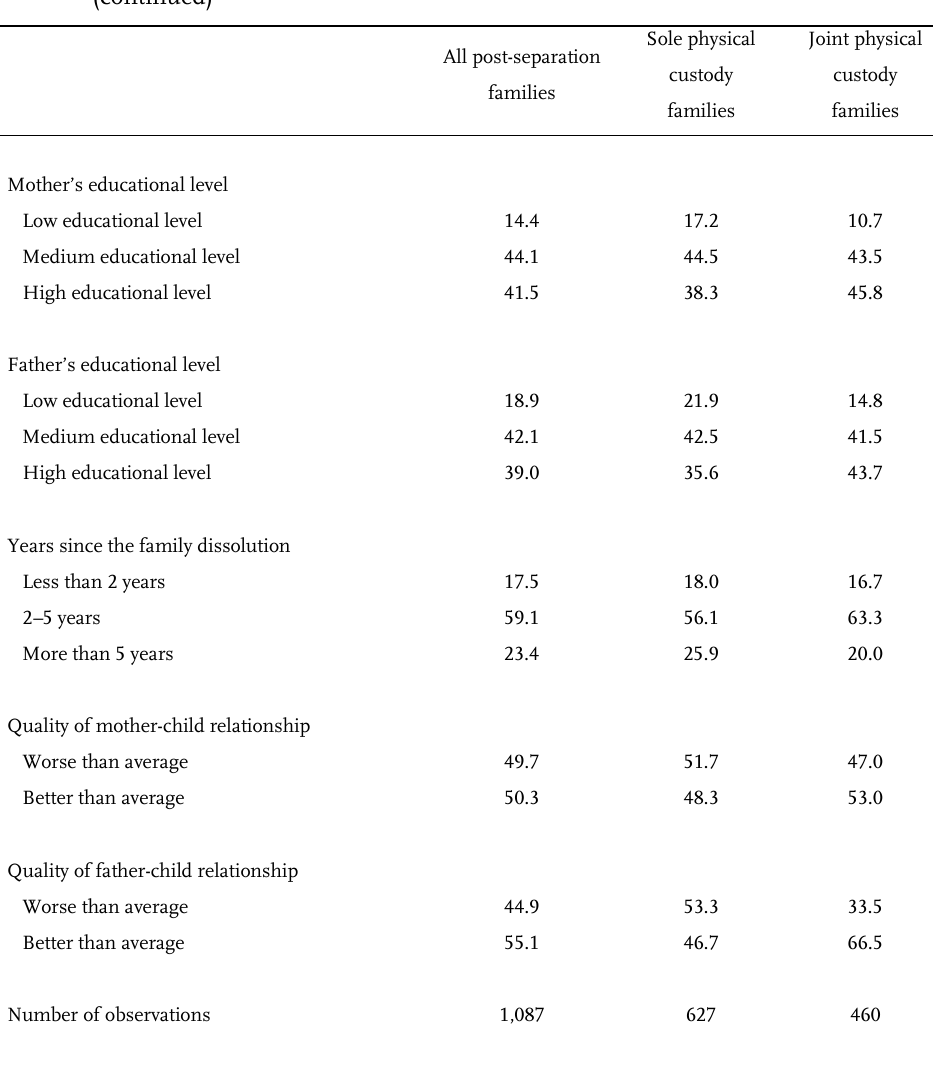
Table 1 : Descriptive sample statistics: Percentages or means (standard deviations)